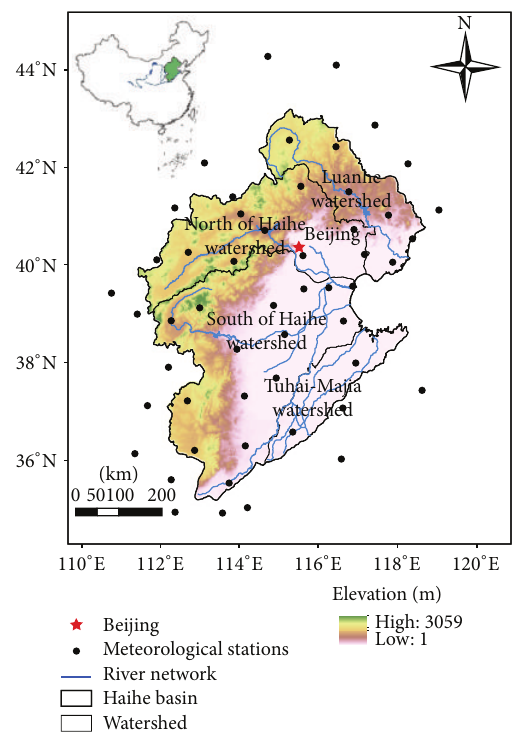
Figure 1: Topographic distribution of Haihe River basin and loca- tion of meteorological stations.